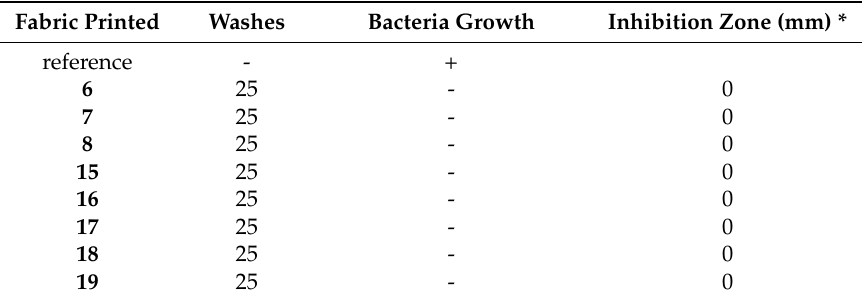
Table 4. Antibacterial features of